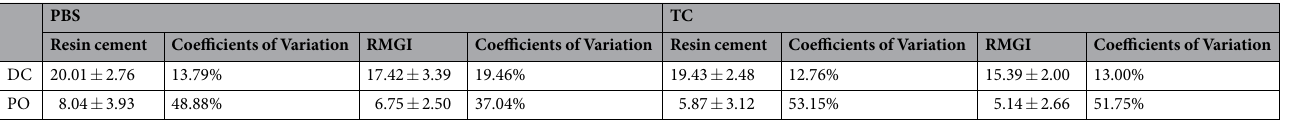
Table 1. Bond strength (MPa) of post-dentin disks for each group. The data shown are the means ± standard deviations. DC – diametral compression; PO – push-out